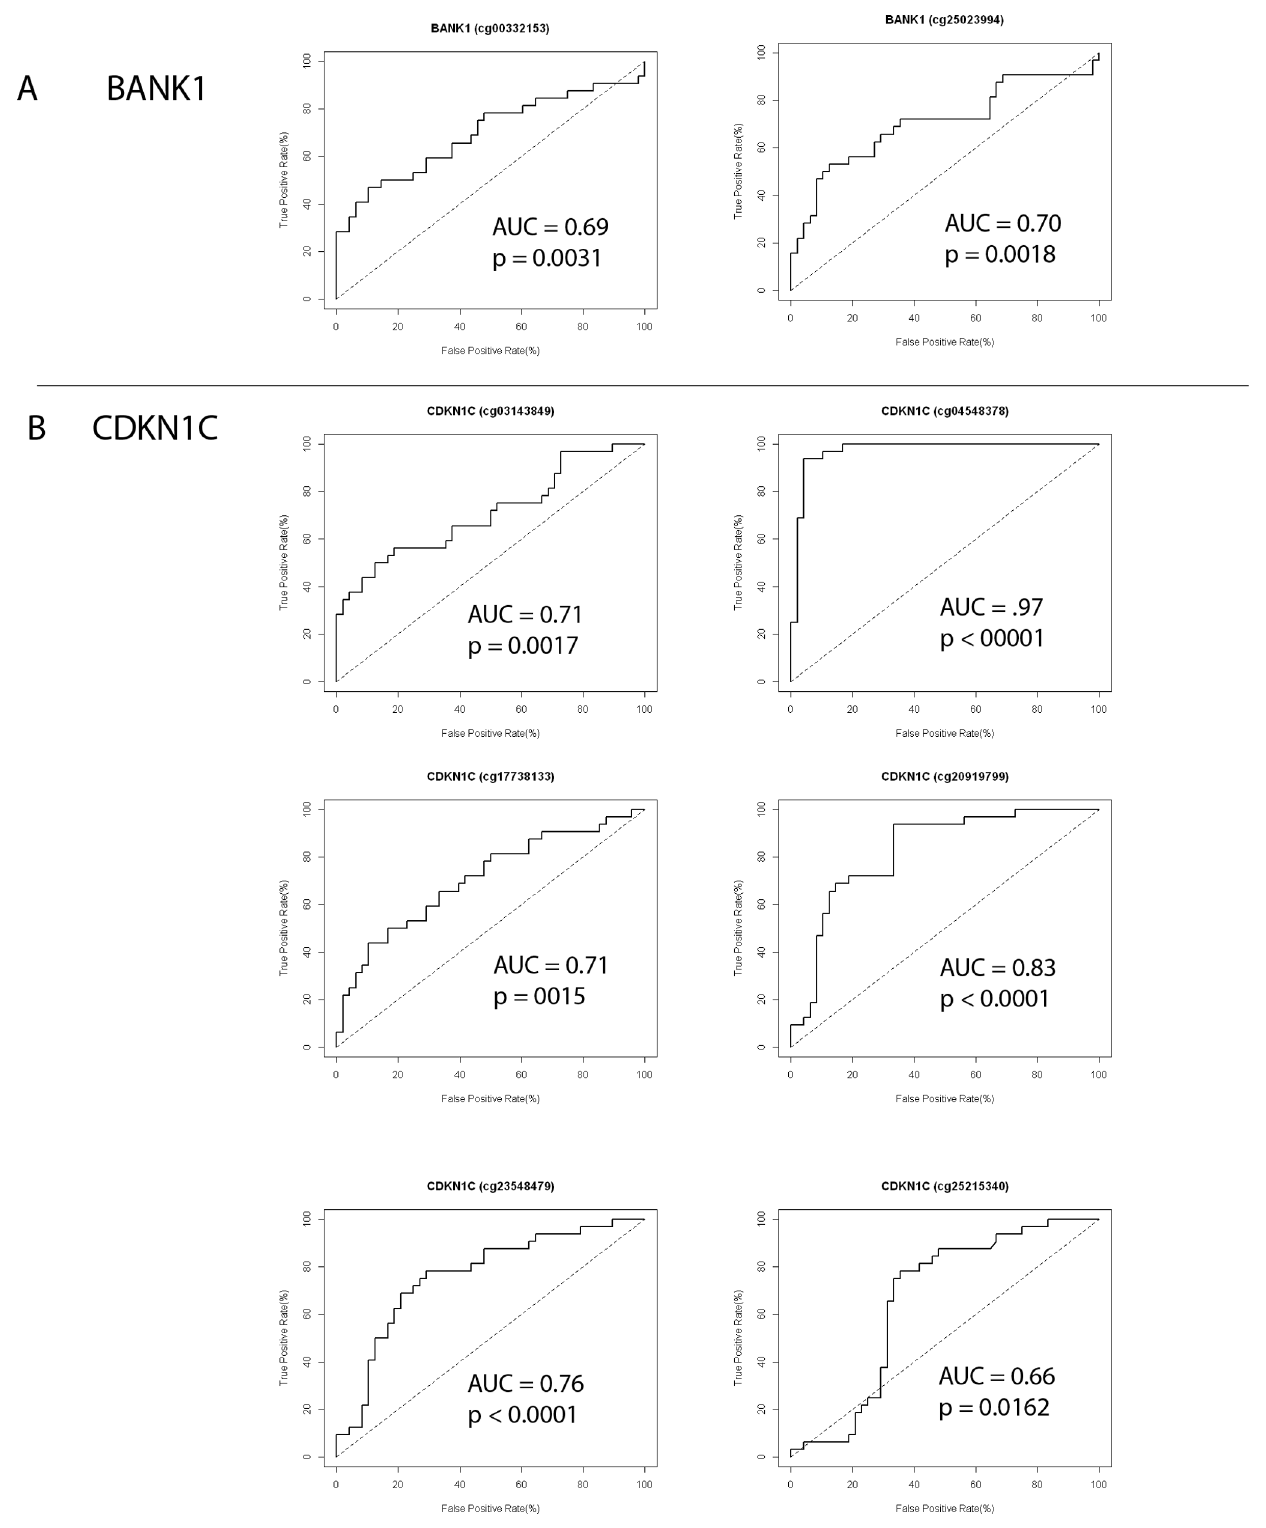
Figure 6. Receiver Operator Characteristic (ROC) Curve for BANK1 and CDKN1C for Determining Differential DNA Methylation Between BBM (n=32) and Primary Breast Tumors (n=48). The ROC curve is a graph of the true-positive rate versus the false-positive rate using different threshold values. Data plotted represent two BANK1 HumanMethylation27 array probes and 6/8 CDKN1C probes that demonstrate statistically significant differential methylation between BBM and primary tumors. The area under the curve (AUC) and p values are indicated on the graphs.